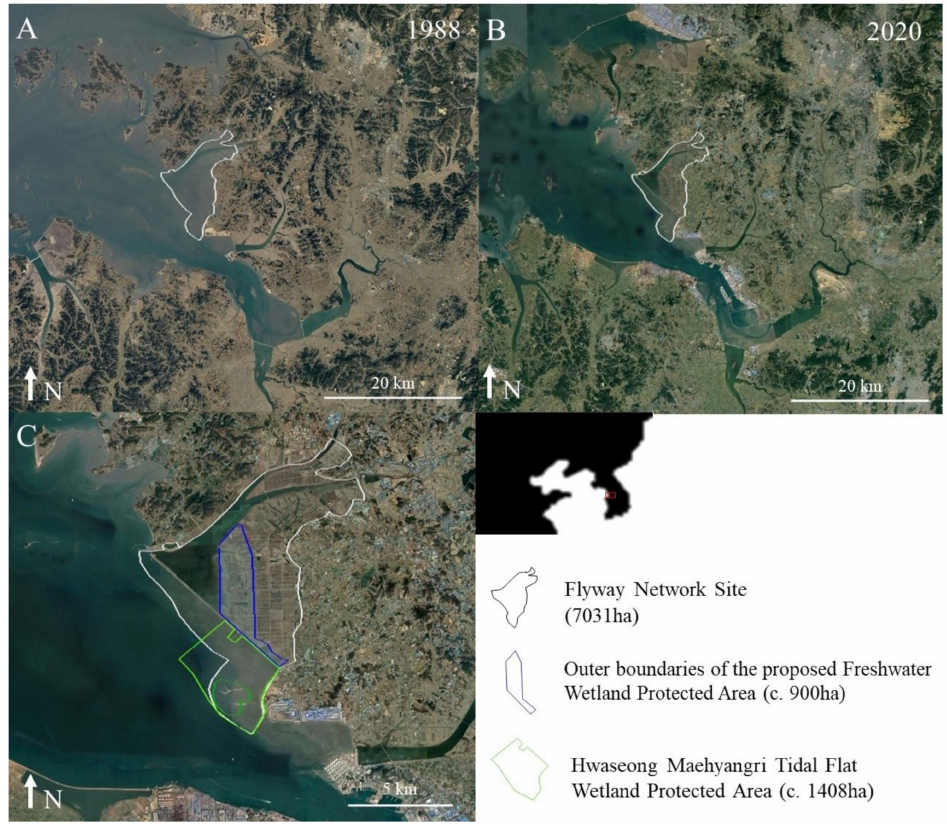
Figure 1. Google Earth (Map data ©2021 Google, Mountain View, CA, USA) images of Hwaseong Wetlands (RO Korea) and adjacent wetlands in 1988 ( A ), the year of the first coordinated shorebird counts, and in 2020 ( B ). ( C ) Areas along the Hwaseong coast referred to in the text. The white polygon indicates the revised outer boundaries of the Hwaseong Wetlands FNS based on the present research (retaining the total area of 7031 ha by extending boundaries in freshwater areas and reducing the